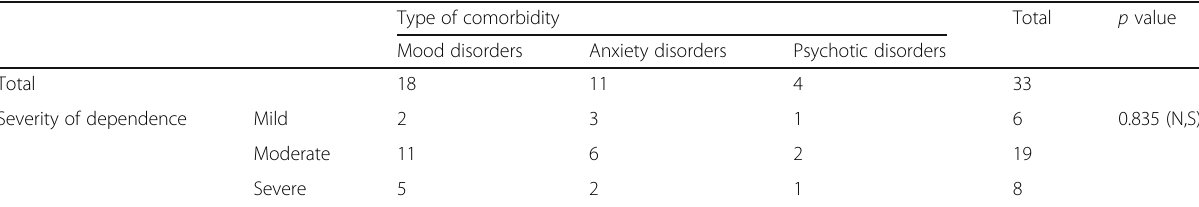
Table 7 Comparison of types of psychiatric comorbidity in relation with severity of